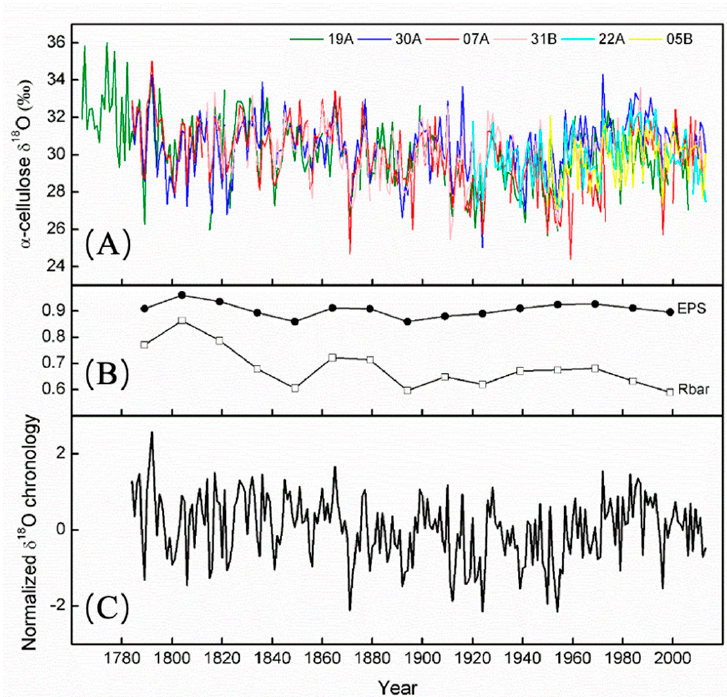
Figure 3. ( A ) Tree ring δ 18 O series from the six samples in this study, ( B ) EPS and Rbar statistics and ( C ) composite normalized δ 18 O chronology of Heng Mountain.